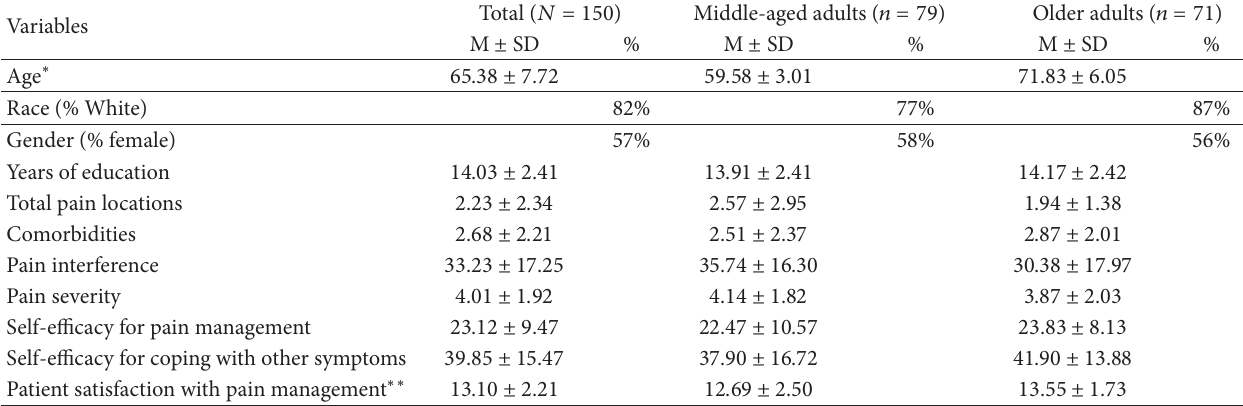
Table 1: Descriptive statistics for total sample and middle-aged and older